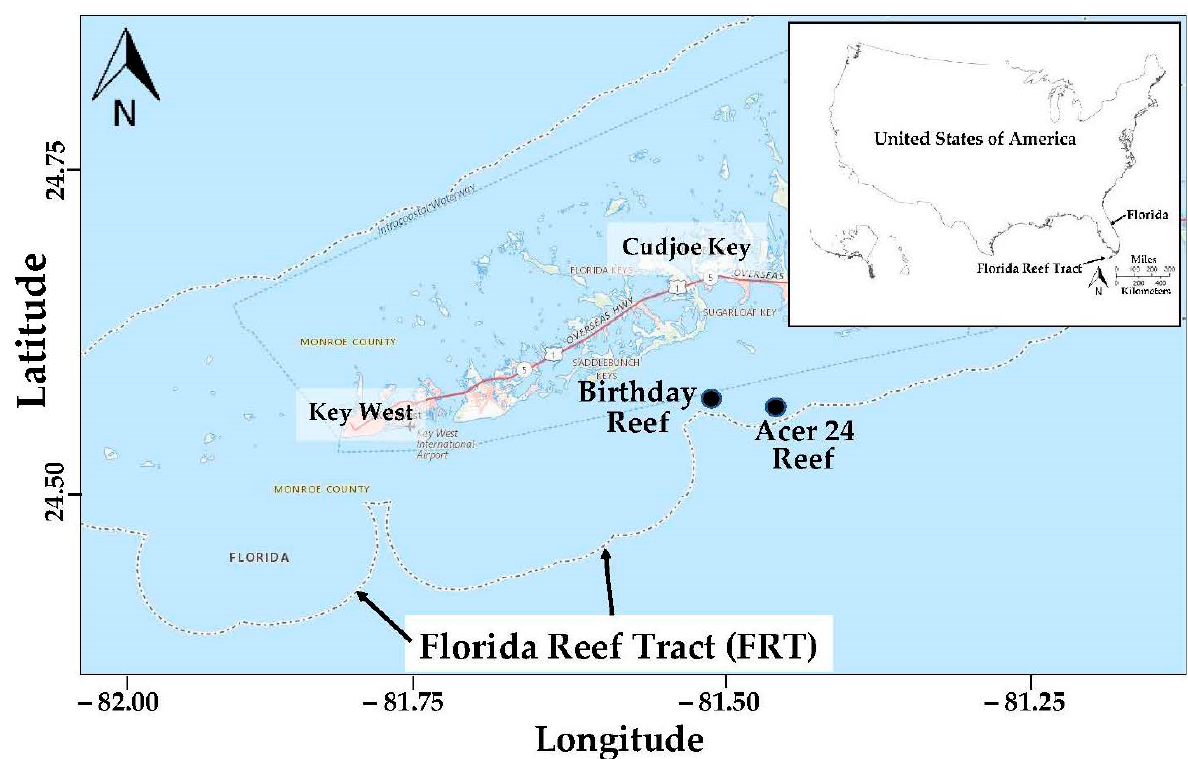
Figure 1. Insert (top right) shows the study site (black circle) located in the Florida Reef Tract (FRT) in Florida, USA. The lower FRT, located in the Florida Keys near Key West (USA) show the specific sample sites (larger figure). The inshore patch reef, Birthday Reef, is represented by a square and the offshore bank reef, Acer 24, reef is represented by a triangle.